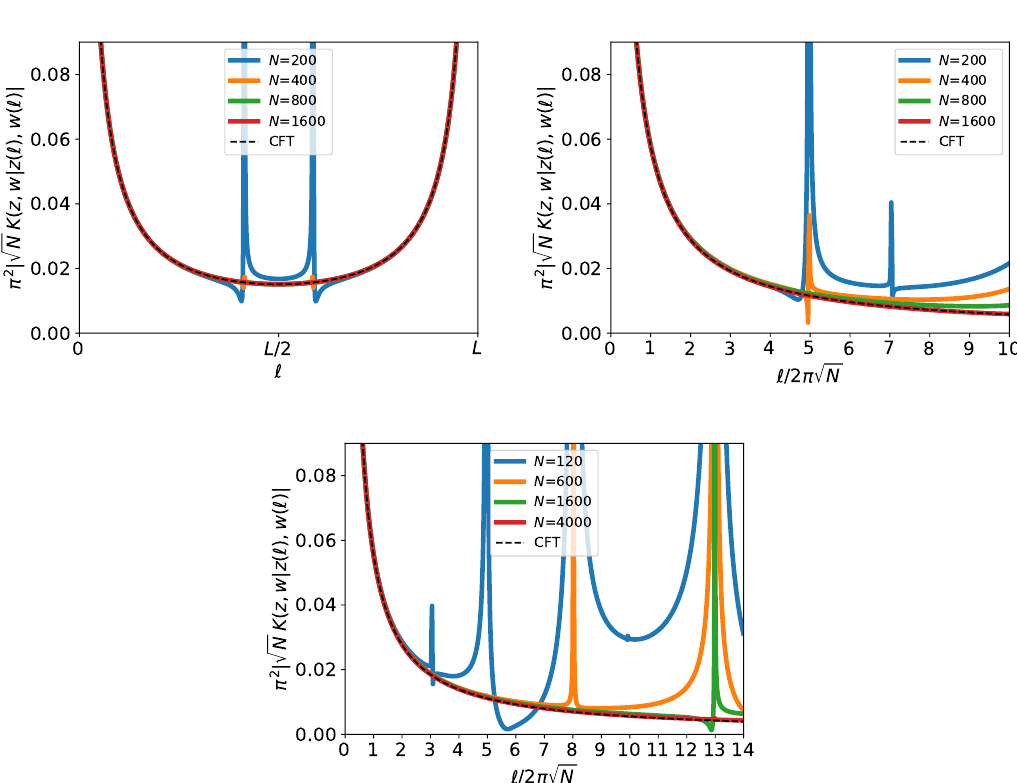
Figure 11: Numerical computation of the rescaled correlator along the classical tra- jectory, for several values of N . Left: rational case ∆ = 17 / 12, perfectly reproducing (cid:112) the CFT correlator (21) on a circle. Right: irrational case ∆ = 2, with integer ab- scissae indicating the number of times the trajectory wraps around the torus. Bottom: (cid:112) + 5 golden ratio ∆ = 1 . The agreement with the CFT correlator (26) on an infinite 2 line is excellent. Notice the bumps in the curves with relatively small N : these are finite-size effects, due to the fact that the Gaussian spread is too large for small N and that the classical trajectory is not yet sharply resolved. Intriguingly, the locations of these bumps coincide with the denominators obtained by truncating the continued fraction. This is manifest in the Fibonacci sequence 1,1,2,3,5,8,13,... of the bottom plot. (The first few denominators are not visible because particle number is already too